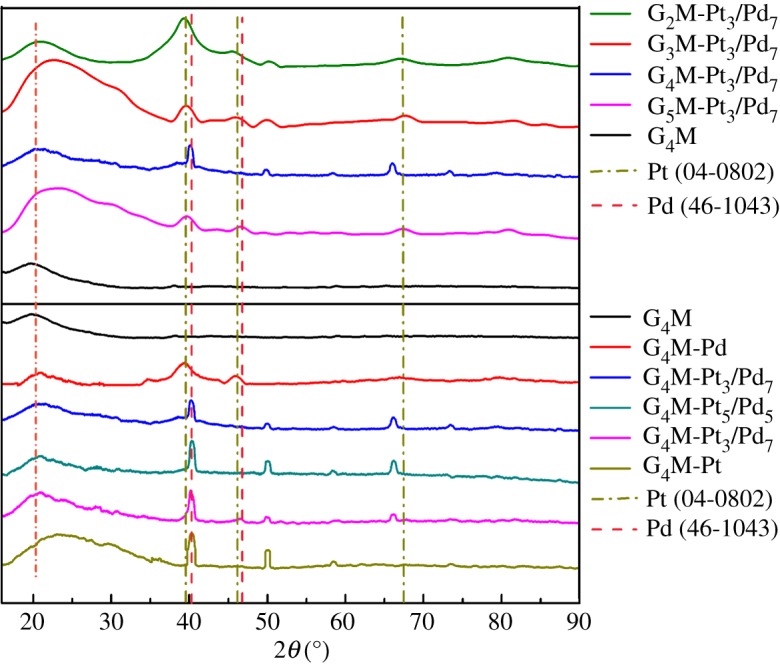
XRD patterns of G4M and GnM-(Ptx/Pd10−x) (n = 2, 3, 4, 5).